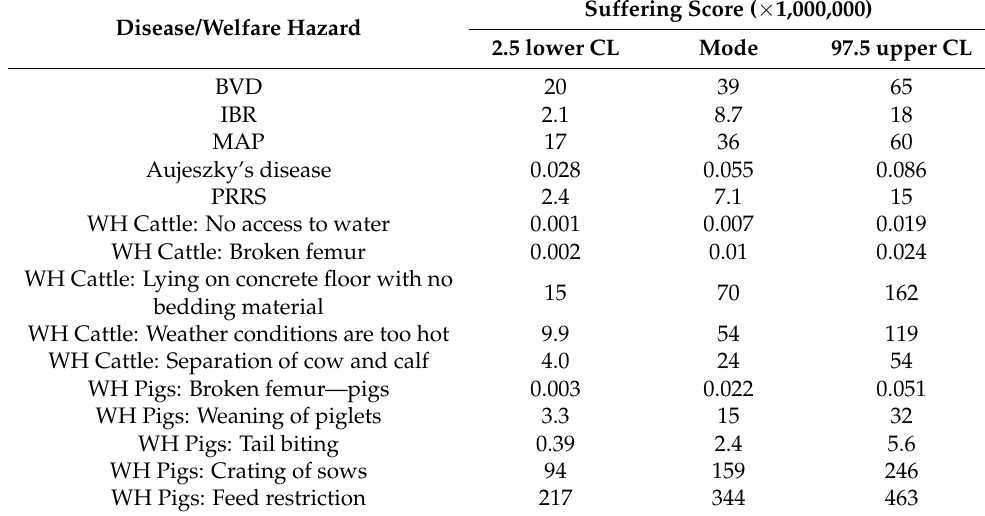
Table 6. Suffering scores for four infectious diseases in cattle and two infectious diseases in pigs, five welfare hazards in cattle, and five welfare hazards in pigs. The suffering scores pertain to a population of 1 million animals in a year, but because the durations vary, the effect of short-term incidents (such as no access to water) can be less than for long-term incidents (such as lying on a concrete